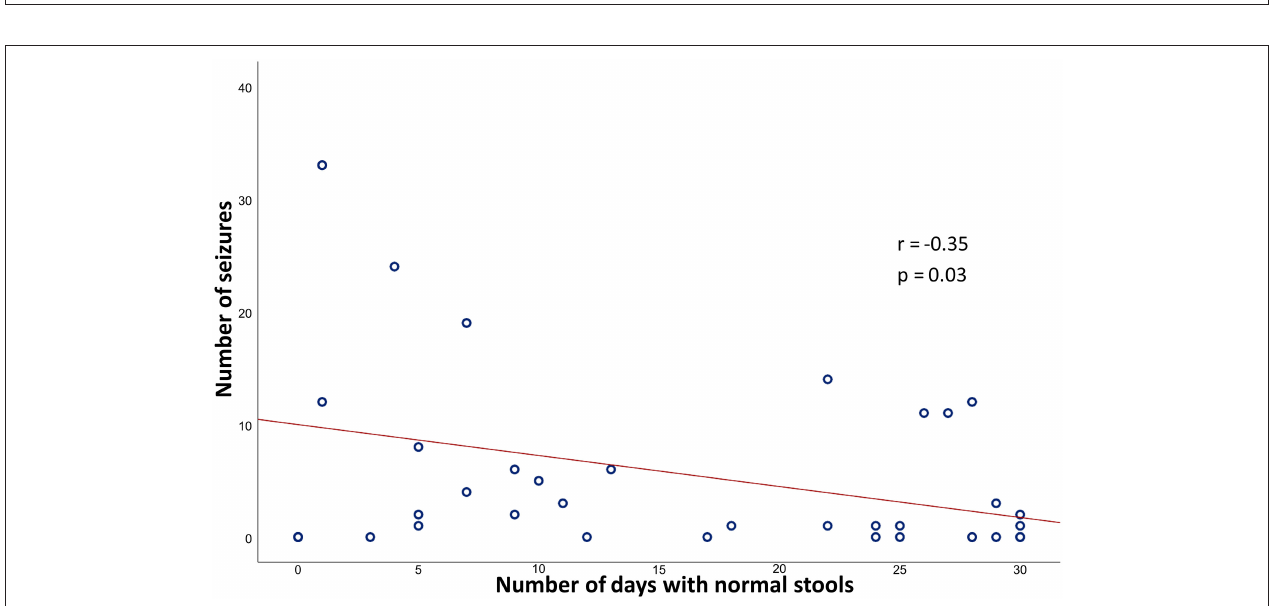
FIGURE 1 | Seizure distribution according to Bristol categories in patients with drug-resistant epilepsy. The graph shows a more frequent occurrence of seizures during periods of altered bowel movements, especially constipation (Bristol score 1–2), as compared with periods of normal stools (Bristol score 3–5).